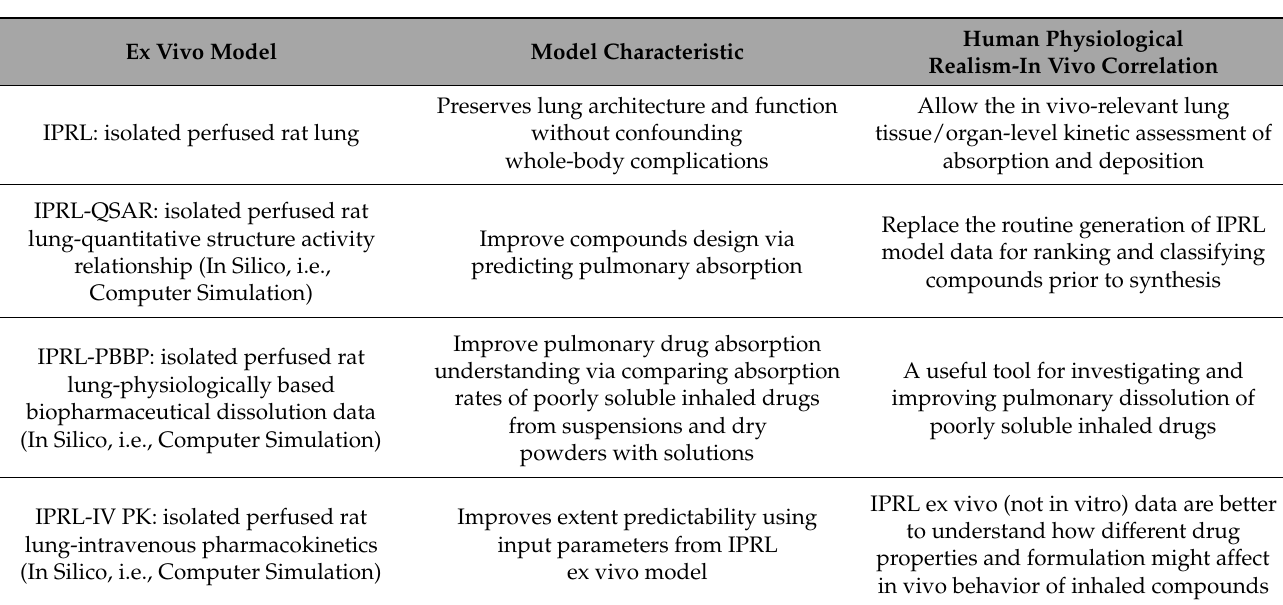
Figure 15. Schematic representation: ( A ) Physiologically-based biopharmaceutical (PBBP) model for (K diss ) estimation. ( B ) Computational analysis for IPRL (K absorp ) estimation. Table 4. Summary of ex vivo lung tissue/organ-based models for testing inhaled aerosolized mist/dried lipid bilayer vesicles.